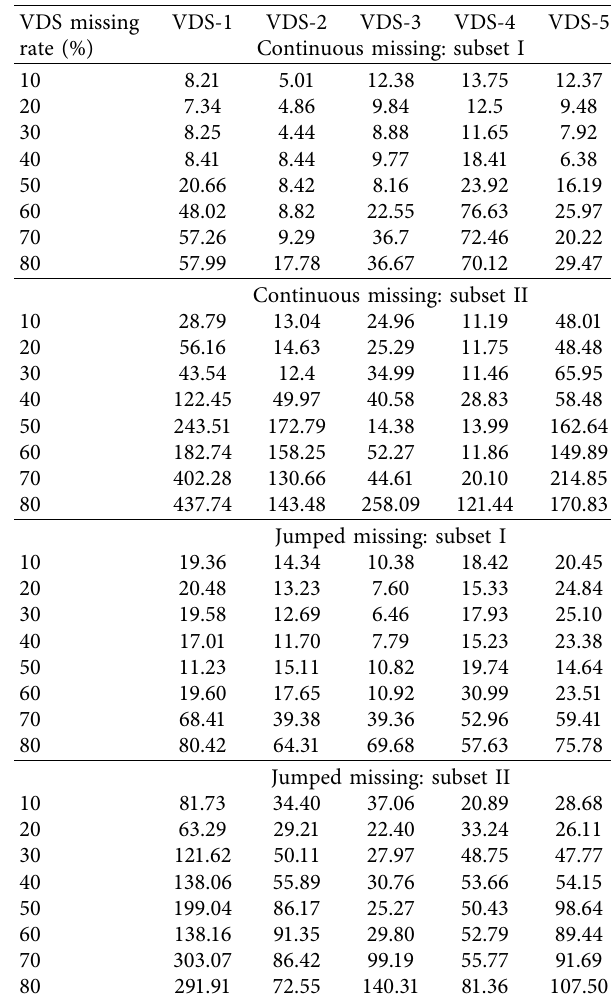
Table 5: Imputation results of continuous missing